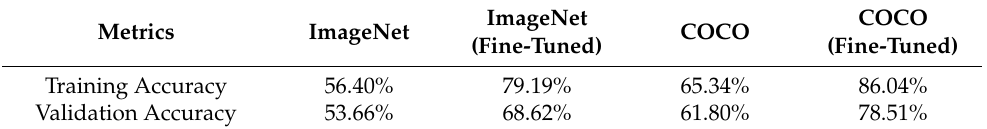
Table 1. Fine-tuning: training accuracy.